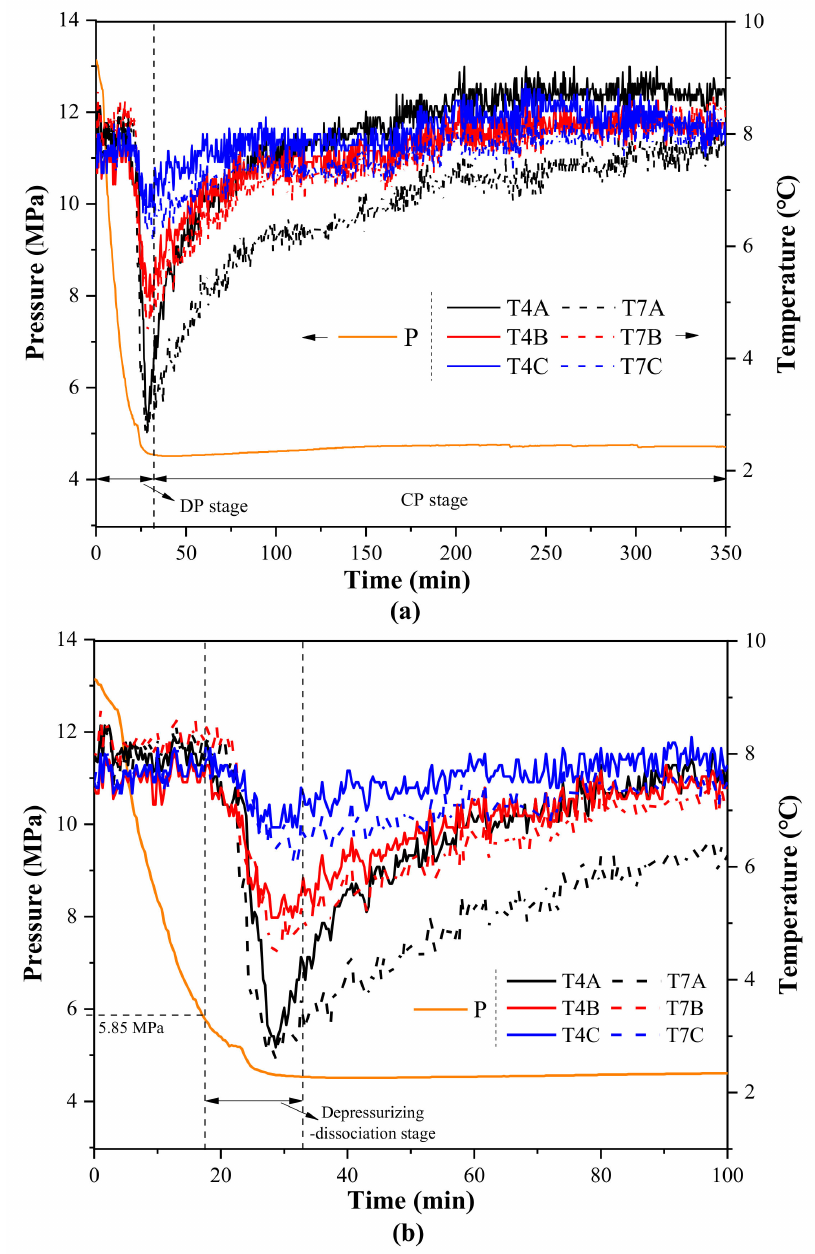
Figure 11. System pressure change and temperature evolutions from the boundary to the center and different horizons of the hydrate-bearing sediment during hydrate dissociation. ( a ) Entire hydrate dissociation process. ( b ) The first 100 min for hydrate